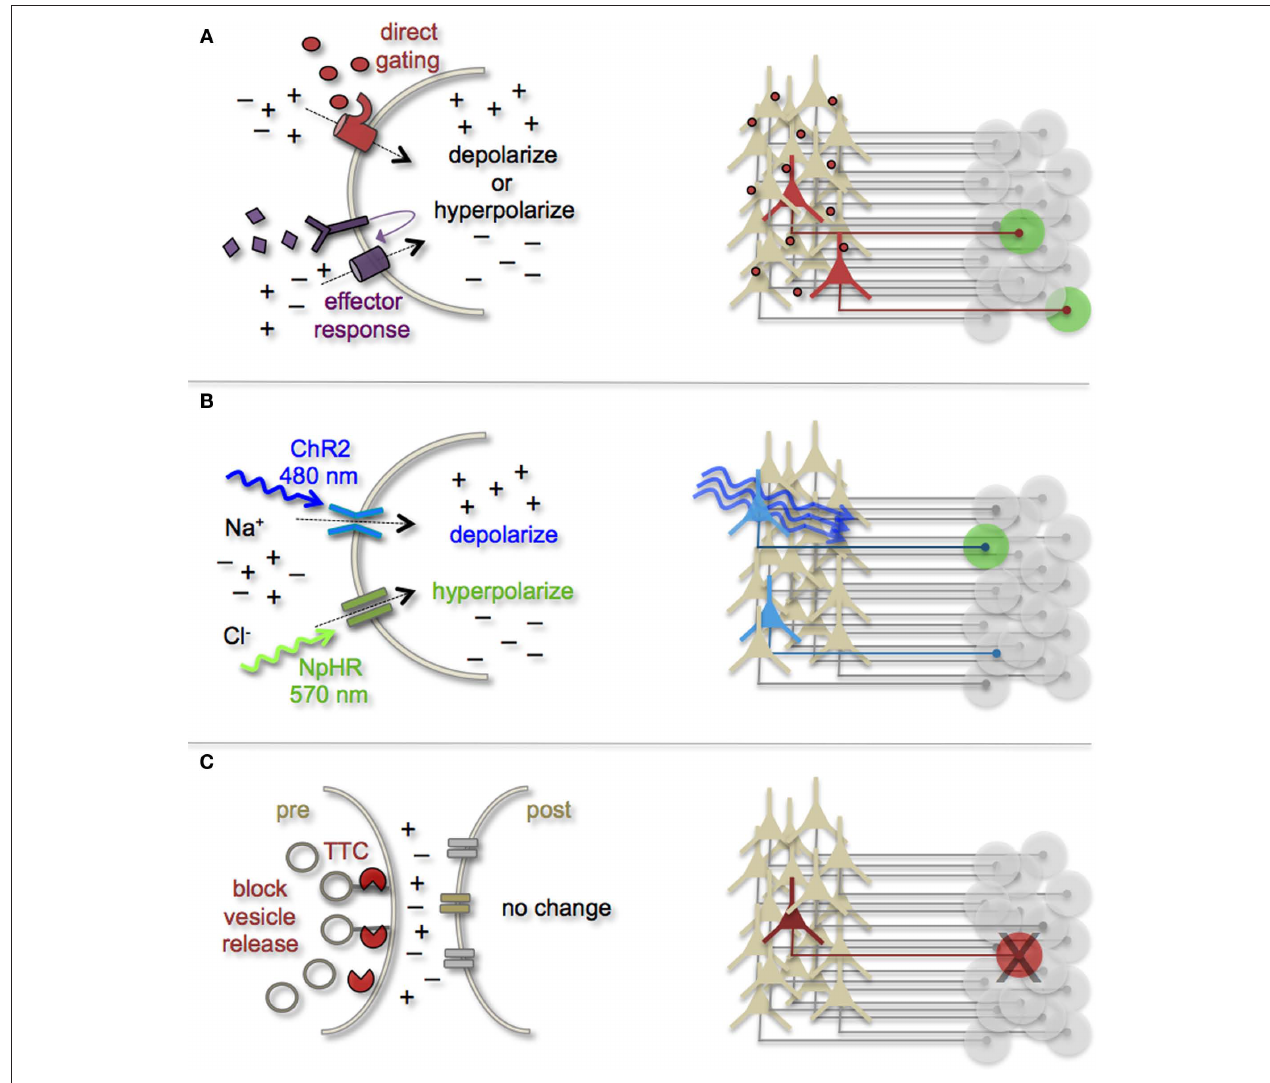
Figure 3 | genetic strategies to mark and manipulate neurons and circuits. (A) Neurons can be targeted for heterologous receptor expression. These foreign receptors can be either directly or indirectly gated by application of exogenous ligands (depicted as red ovals and purple diamonds). Left: heterologous receptor activation via application of synthetic ligands can be used to change a neuron’s ionic equilibrium and thus firing properties. Right: depending on molecular properties, exogenous ligands spread variably throughout brain tissue. All neurons expressing the heterologous receptors are capable of being activated and driving target cell responses (represented as green circles). (B) Expression of light-gated channels can be used to modulate neuronal firing with photons. Left: ChR-2 is a non-selective cation channel that